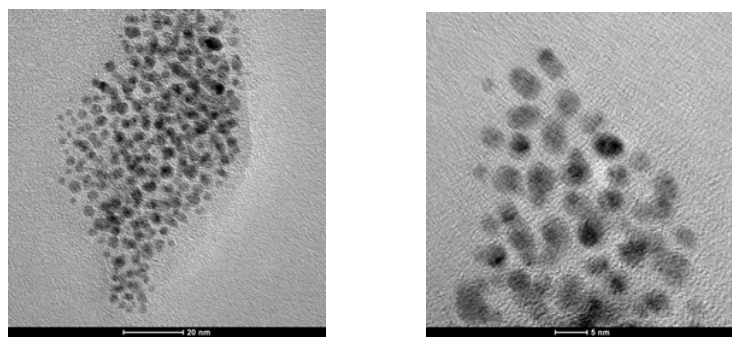
Figure 4. TEM micrographs of G3-Pd.